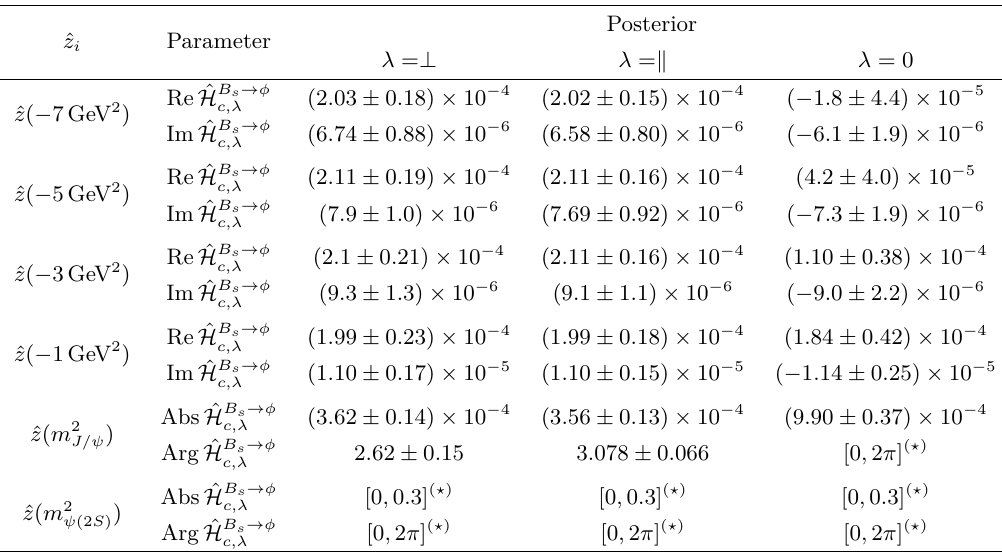
Table 8 . Posteriors of the B s → φ non-local FFs fit. The ranges of the parameters that are not constrained in the fit are marked with a star ( ? ) . These large ranges contain more than 99% of the posterior probability. They are suggested by the authors to reproduce the results of this work, as described in the text. The multinormal distribution describing the constrained parameters is given in the ancillary file BsToPhi-hatH.yaml .